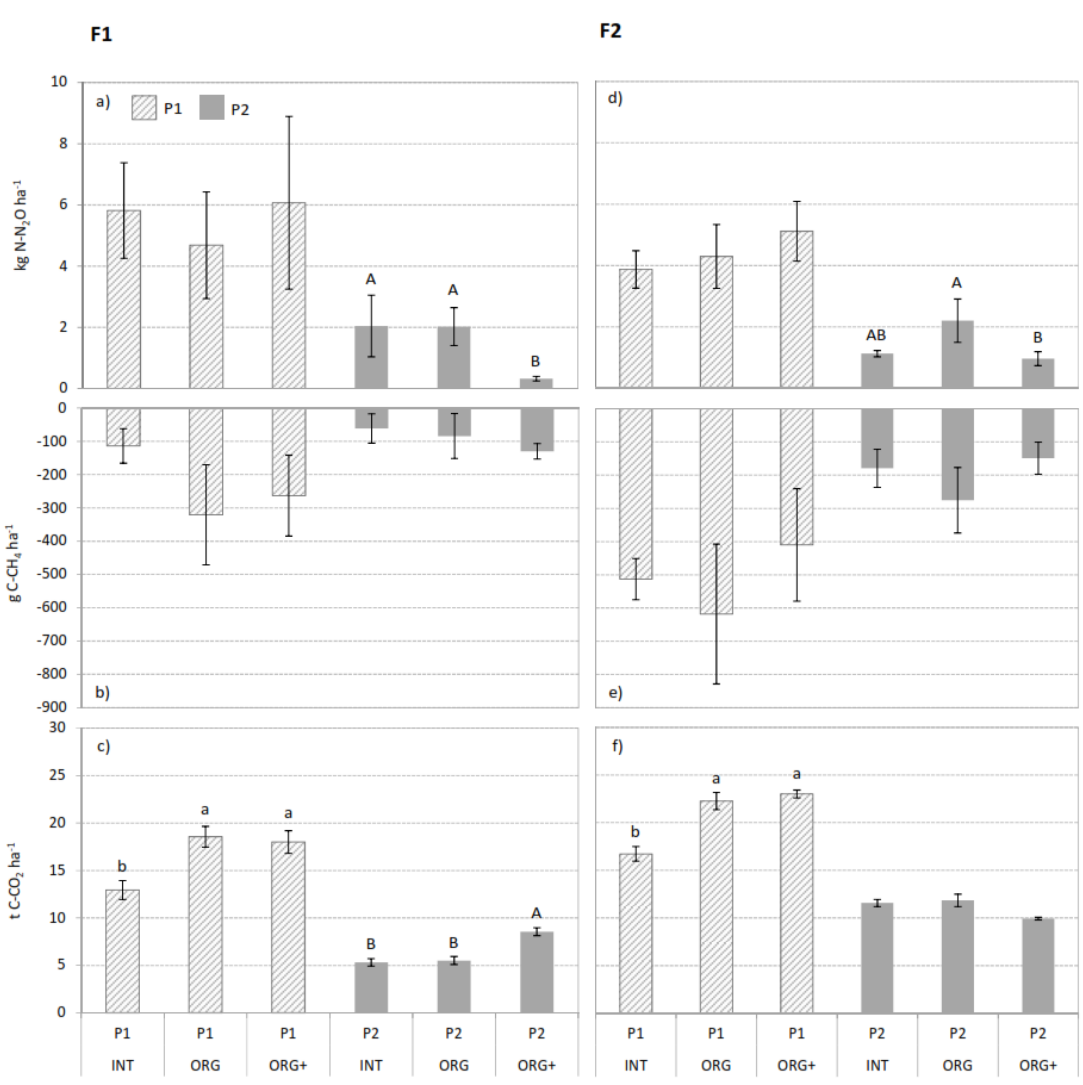
Figure 9. Cumulative emissions of N 2 O (kg N–N 2 O ha − 1 ), CH 4 (g C–CH 4 ha − 1 ) and CO 2 (t C–CO 2 ha − 1 ) for P1 and P2 in field 1 ( a, b, c ) and in field 2 ( d, e, f ), respectively. Di ff erent lowercase letters in P1, and uppercase letters in P2 indicate significant di ff erences between the cropping systems resulting from the post-hoc